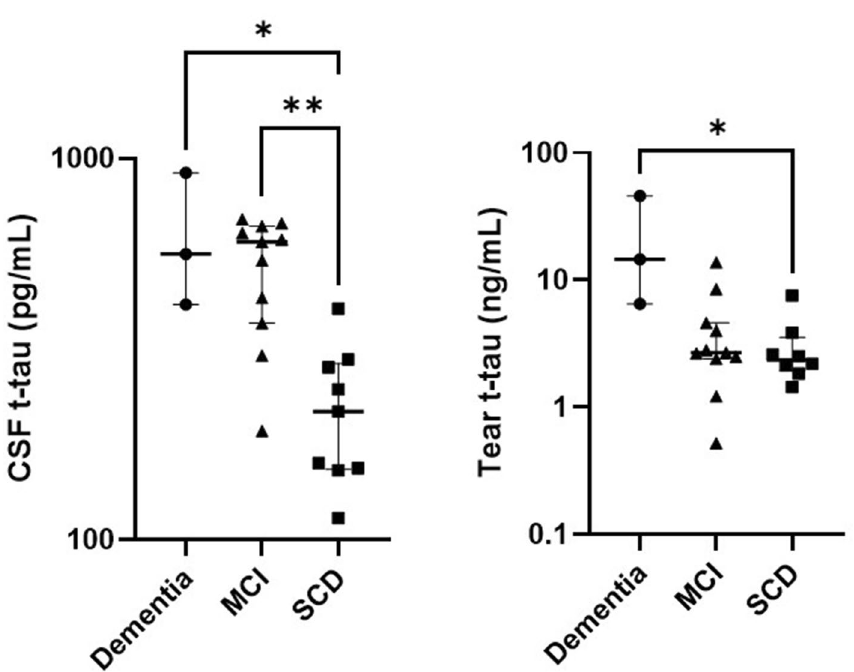
Figure 1. T-tau biomarker levels across diagnostic groups. Evaluation of t-tau in CSF and tear fluid of the CSF group. Bars represent median and IQR. P-values were determined using Kruskal–Wallis testing including Bonferroni correction. *p < 0.05, **p <